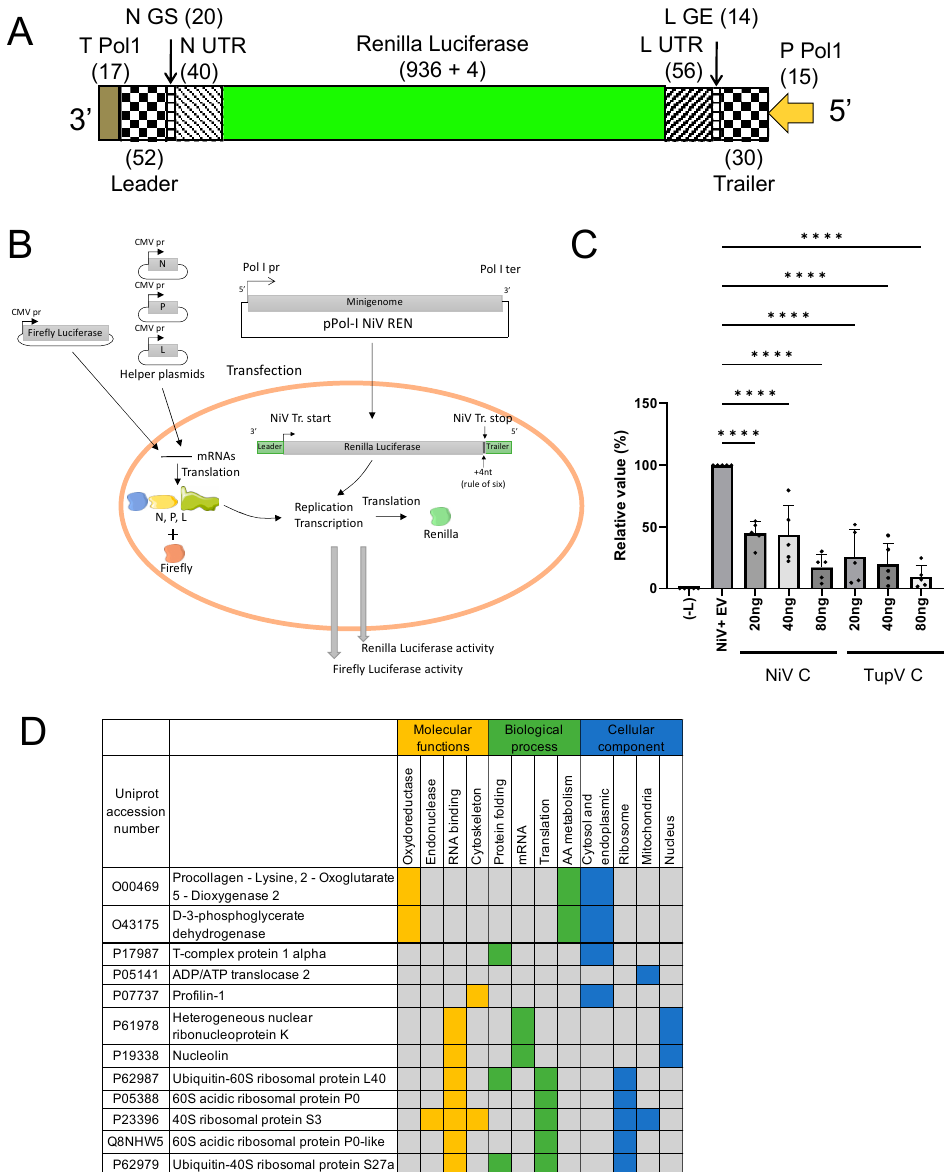
Figure 10. In vivo studies. ( A ) Schematic representation of the RNA minigenome. The scheme drawn as a single strand of negative-sense RNA shows the positions of the Pol1 promoter (P Pol1) and terminator (T Pol1), of the NiV leader, trailer, gene start, and untranslated regions from the N gene (N GS and N UTR), of the gene end and untranslated regions from the L gene (L GE and L UTR) and of the Renilla luciferase, including four bases added to correct the length of the minigenome to be evenly divisible by six. Lengths in nt of the different elements are shown in brackets. ( B ) Schematic representation of the mini-replicon assay. Initially, the minigenome synthesis is controlled by the polymerase I promoter in the pPol I NiV-REN plasmid. The components of the NiV ribonucleoprotein complex (N, P, L) are expressed from helper plasmids under the control of polymerase II (CMV pr). Successful encapsidation of the minigenome RNA will lead to replication of the minigenome and transcription of the reporter gene under the control of NiV polymerase L. Renilla luciferase expression is then used to quantify NiV polymerase activity. A plasmid expressing firefly luciferase under the CMV promoter (CMV pr) is used as a normalization control. ( C ) Effect of NiV and TupV C protein on NiV mini-replicon assay. HEK293T cells were transfected with plasmids encoding Nipah viral N, P, and L proteins and one NiV minigenome encoding Renilla luciferase. A plasmid encoding Firefly luciferase for normalization. In the negative control (-L), the plasmid encoding NiV L was omitted. Increasing plasmid amounts of NiV C or TupV C were co-transfected as indicated, while the amount of transfected plasmid DNA was kept constant by the addition of the